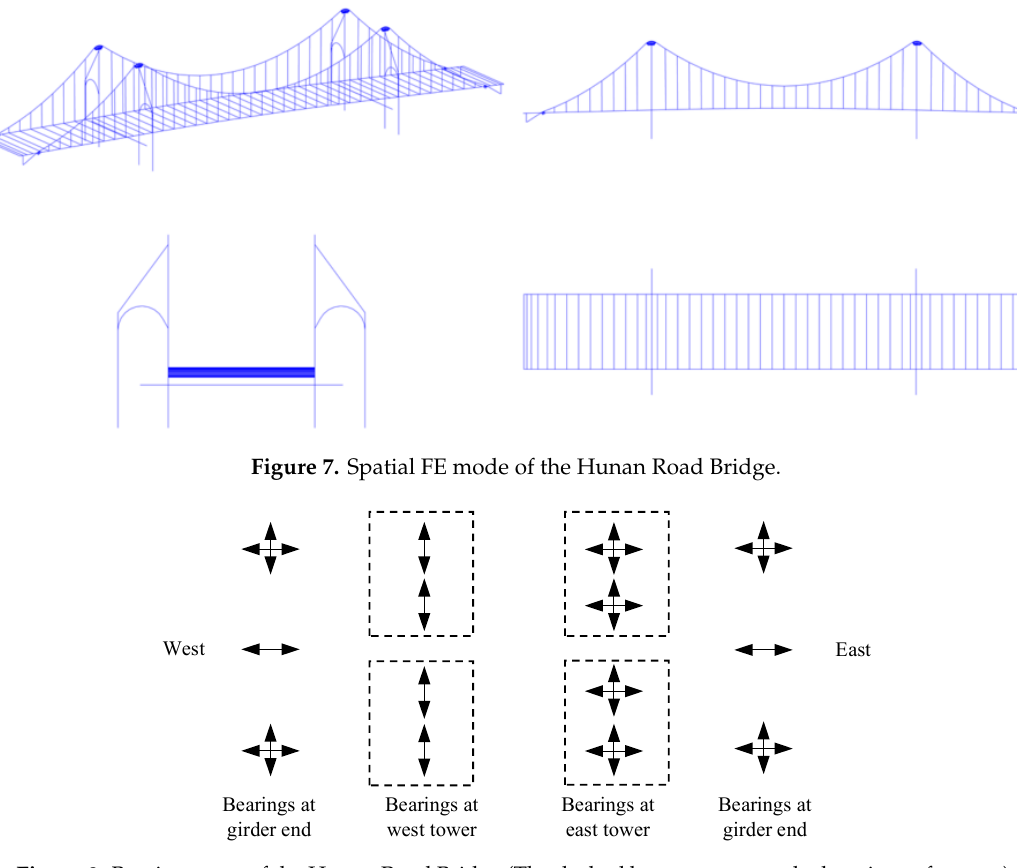
Figure 8. Bearing types of the Hunan Road Bridge (The dashed boxes represent the locations of towers). Table 1. Typical cross-sectional properties and material parameters of the Hunan Road Bridge.